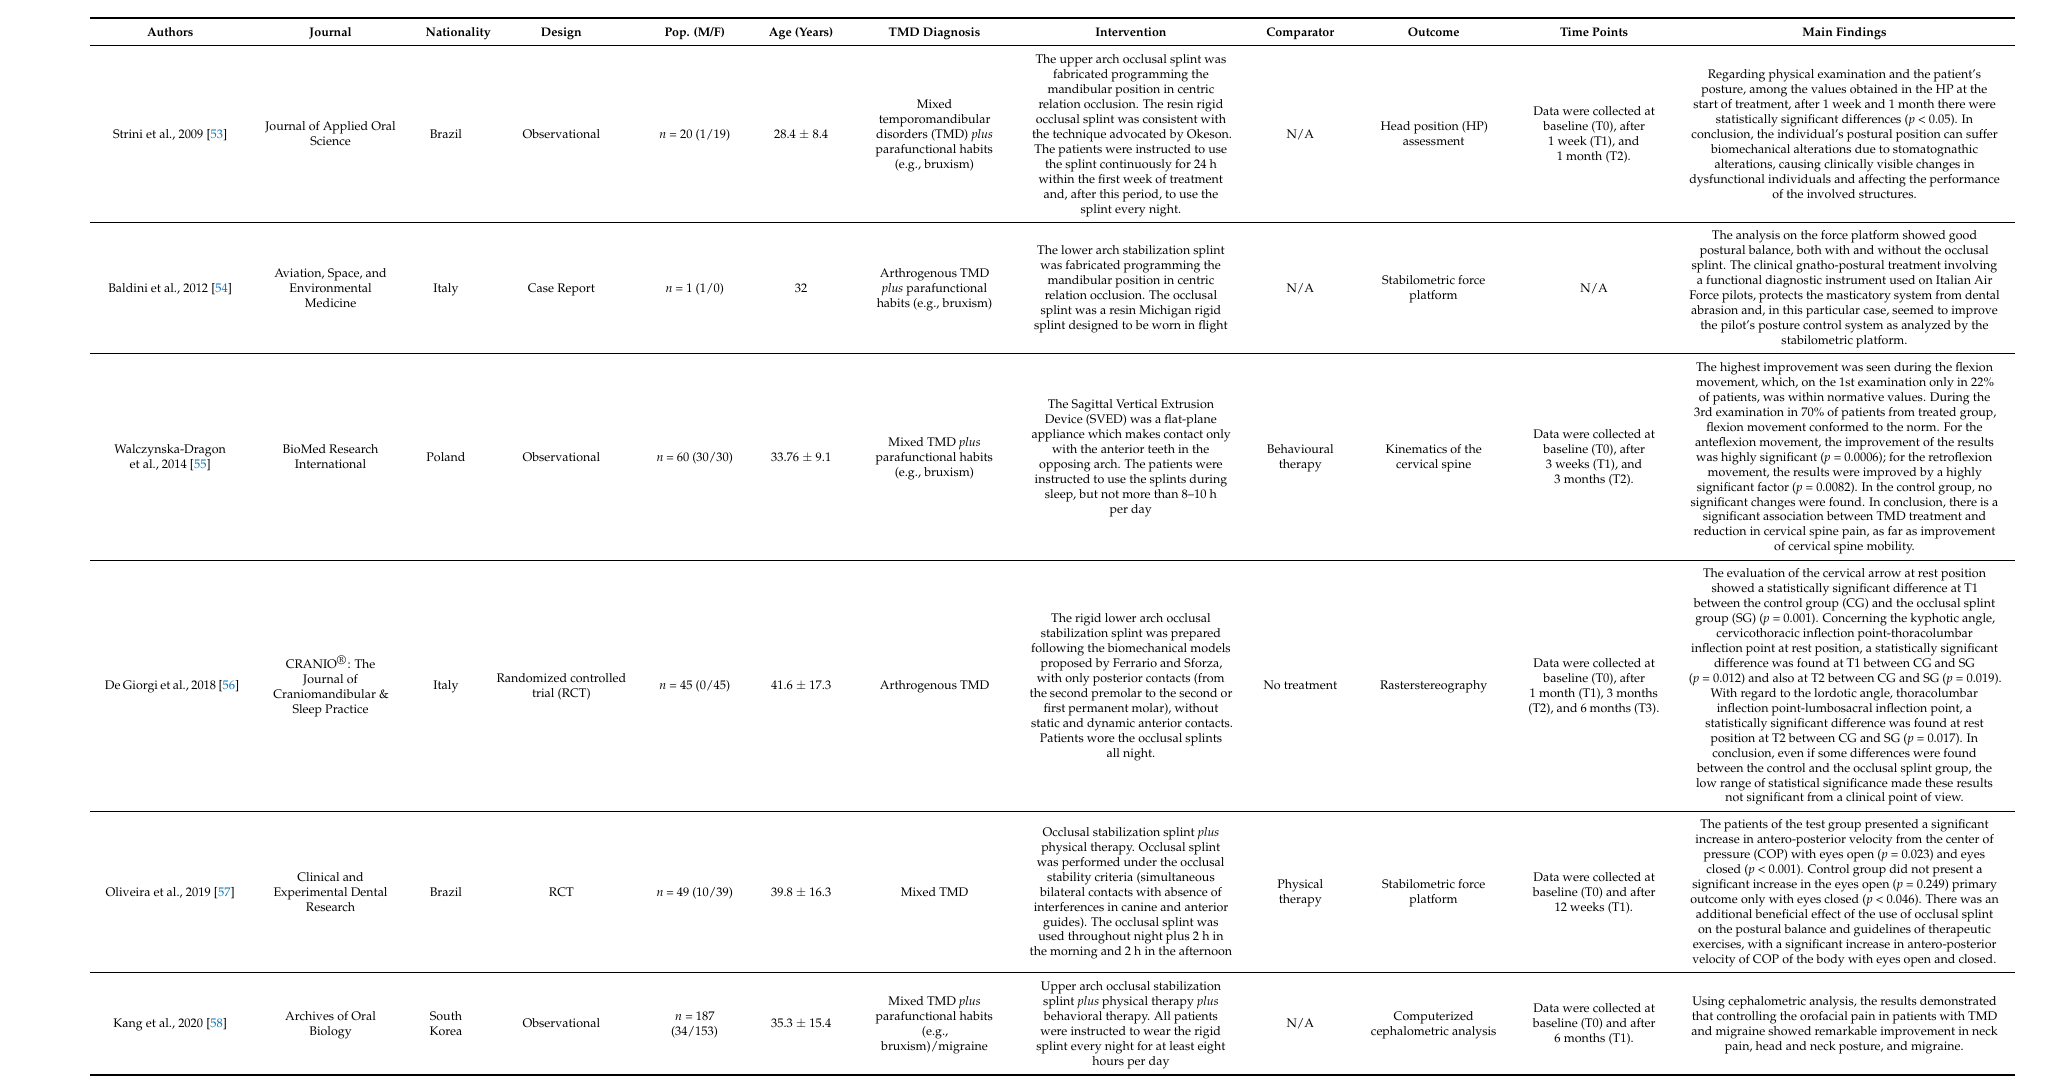
Table 3. Main characteristics of the studies included in the systematic